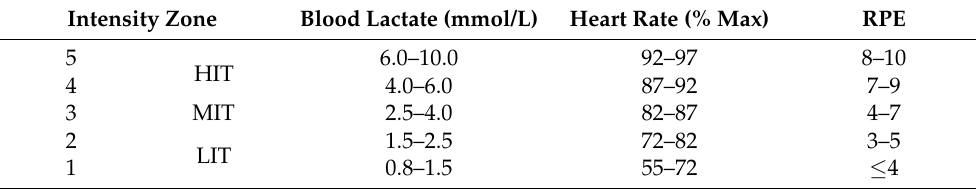
Table 1. The 5-zone model was used in the current study.